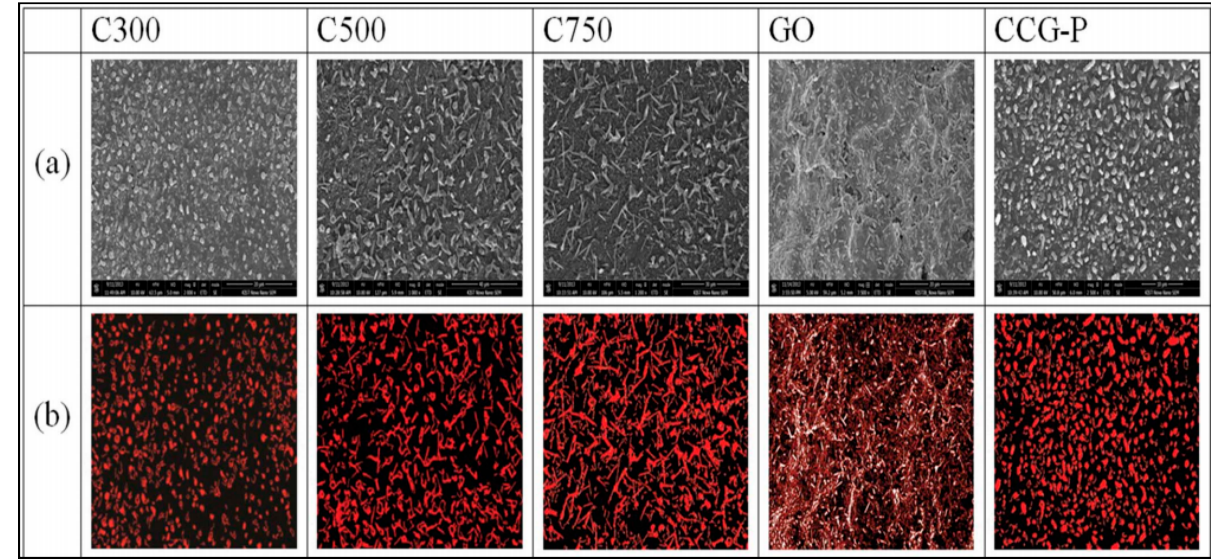
Figure 5. ( a ) SEM images, ( b ) digitally processed SEM images of the distance between fillers of C GNP filled (C300, C500 and C750), GO filled, and CCG-P filled pCBT composites. Reproduced with permission from [47].